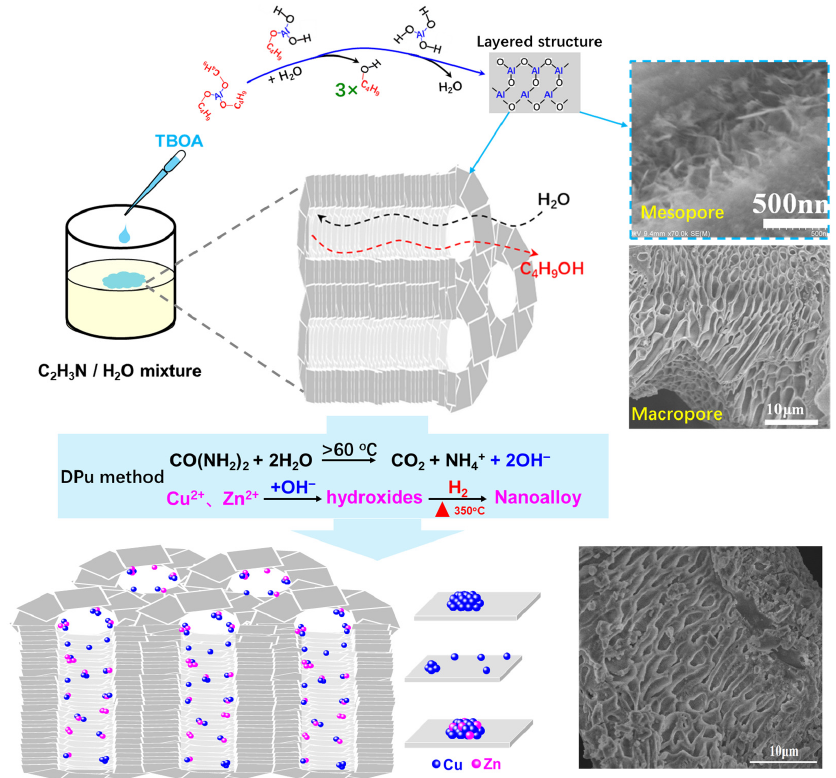
Figure 1. Illustration of the synthesis of a hierarchically porous alumina supported bi-metallic Cu– Zn